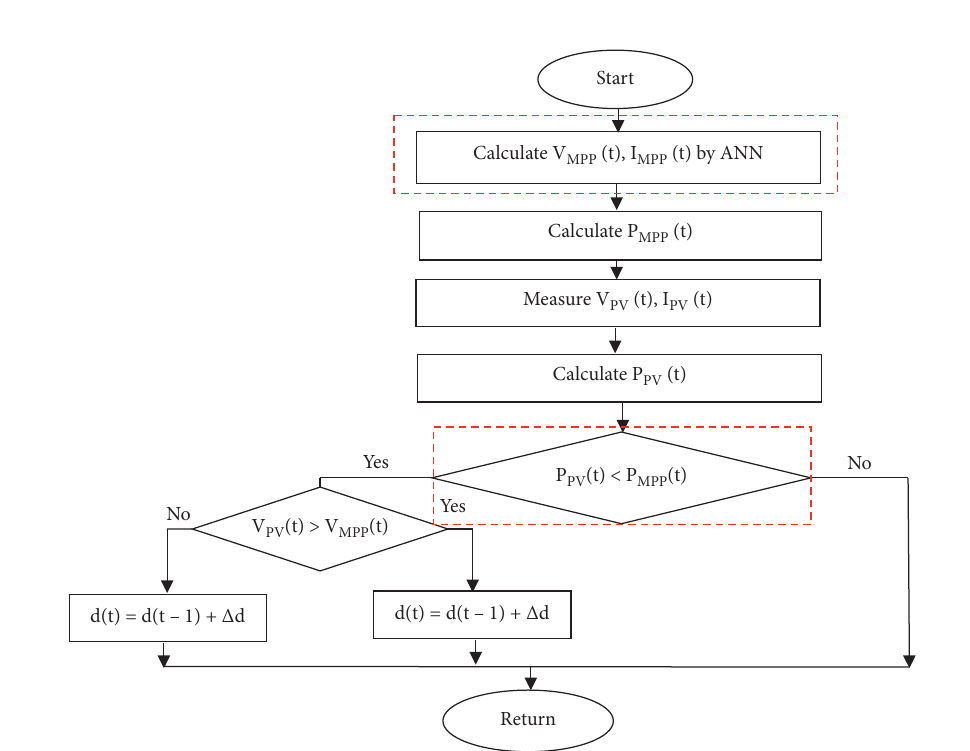
Figure 12: Flowchart of the proposed P&O algorithm.